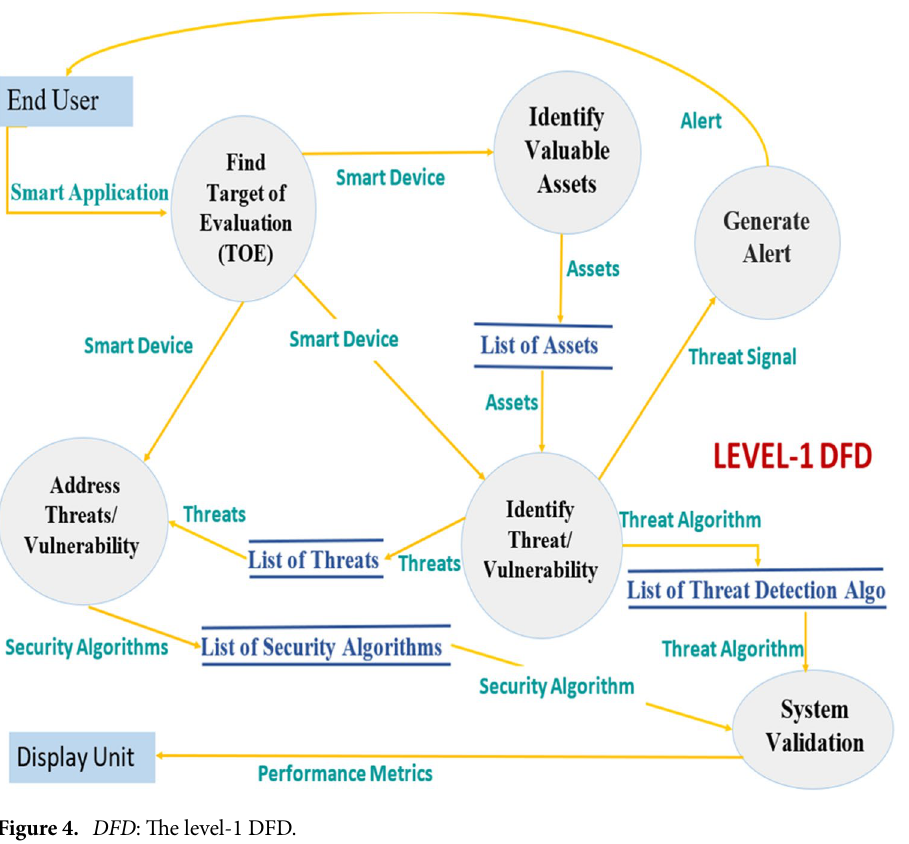
Figure 4. DFD : The level-1